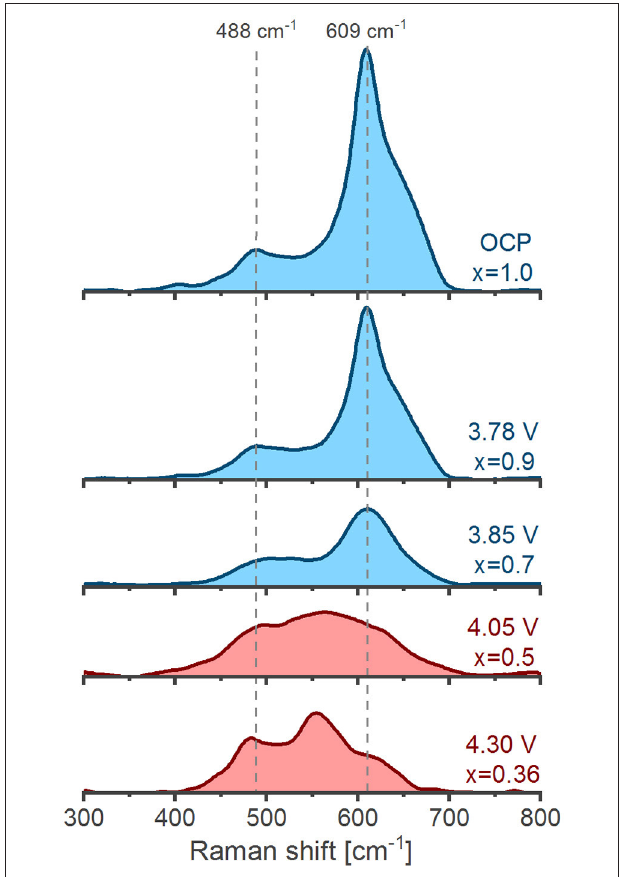
FIGURE 8 | Operando Raman spectra of NCM111 during charge. The evolution of the spectral envelopes is classified into an initial general weakening stage (blue) and a later envelope transformation stage